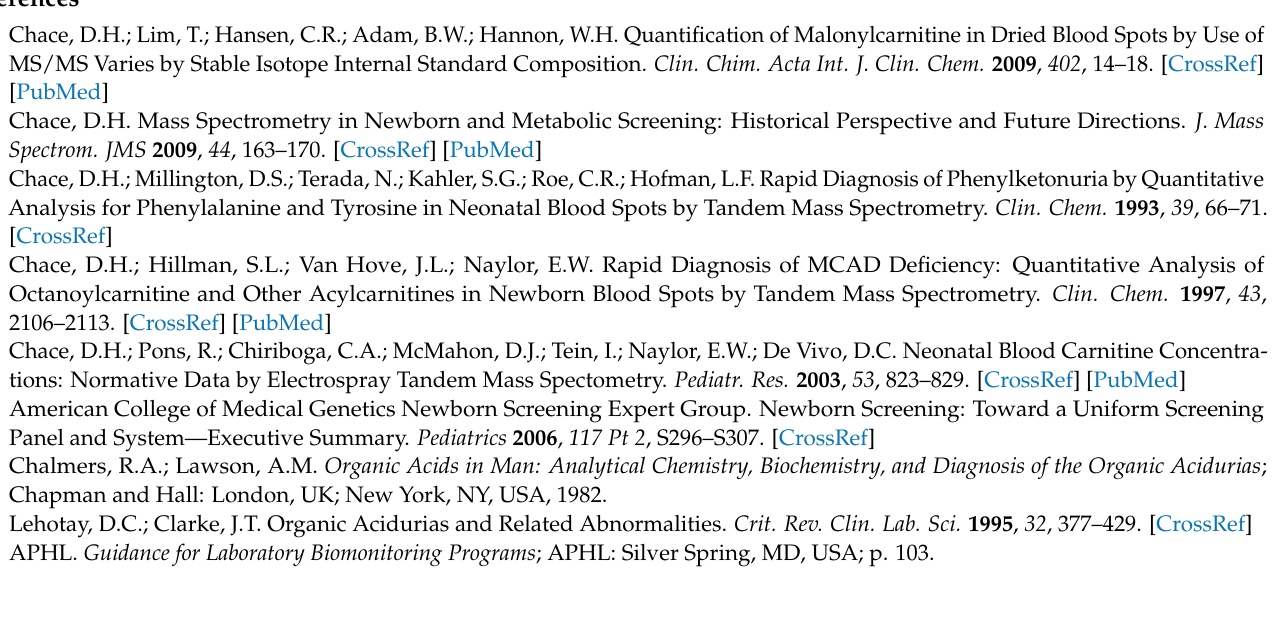
Table S4. Quantitative HPLC-MS/MS measurements of amino- and carboxylic acids in duplicates obtained from samples of primary human lung fibroblasts (HLF) cell culture. Unit of measurement, µ M, or 10 –6 M.